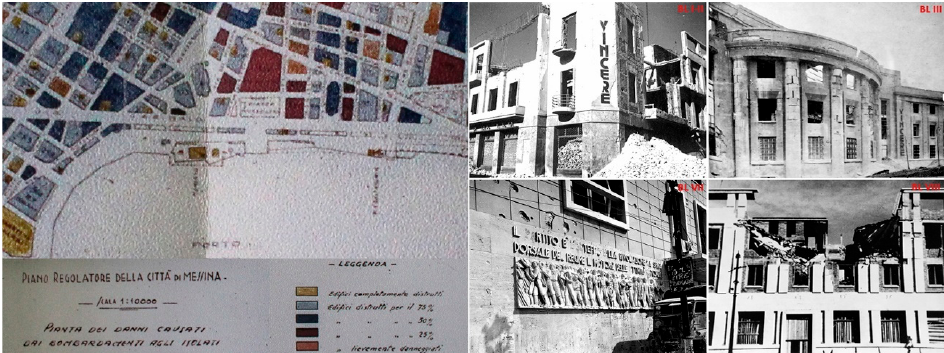
Figure 5. The war damage detected by the civil engineers ( left ) and the photos that a tt est to the real state of consistency of the Palazzata ( right